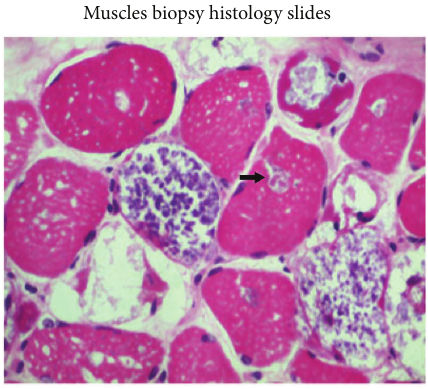
Figure 1: Hematoxylin and Eosin (H&E) staining shows vacuolar myopathy.